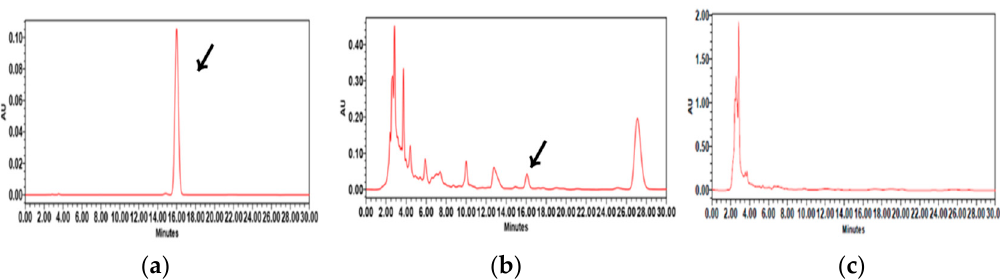
Figure 10. HPLC chromatogram of ( a ) ρ -coumaric acid and hot-water extracts of the leaf ( b ) and branch ( c ) of S. samarangense . ( c ) of S. samarangense